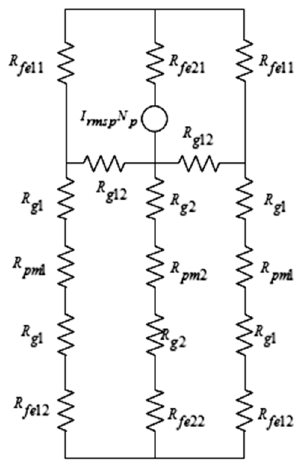
Figure 7. The equivalent magnetic circuit related to the winding of each pole.